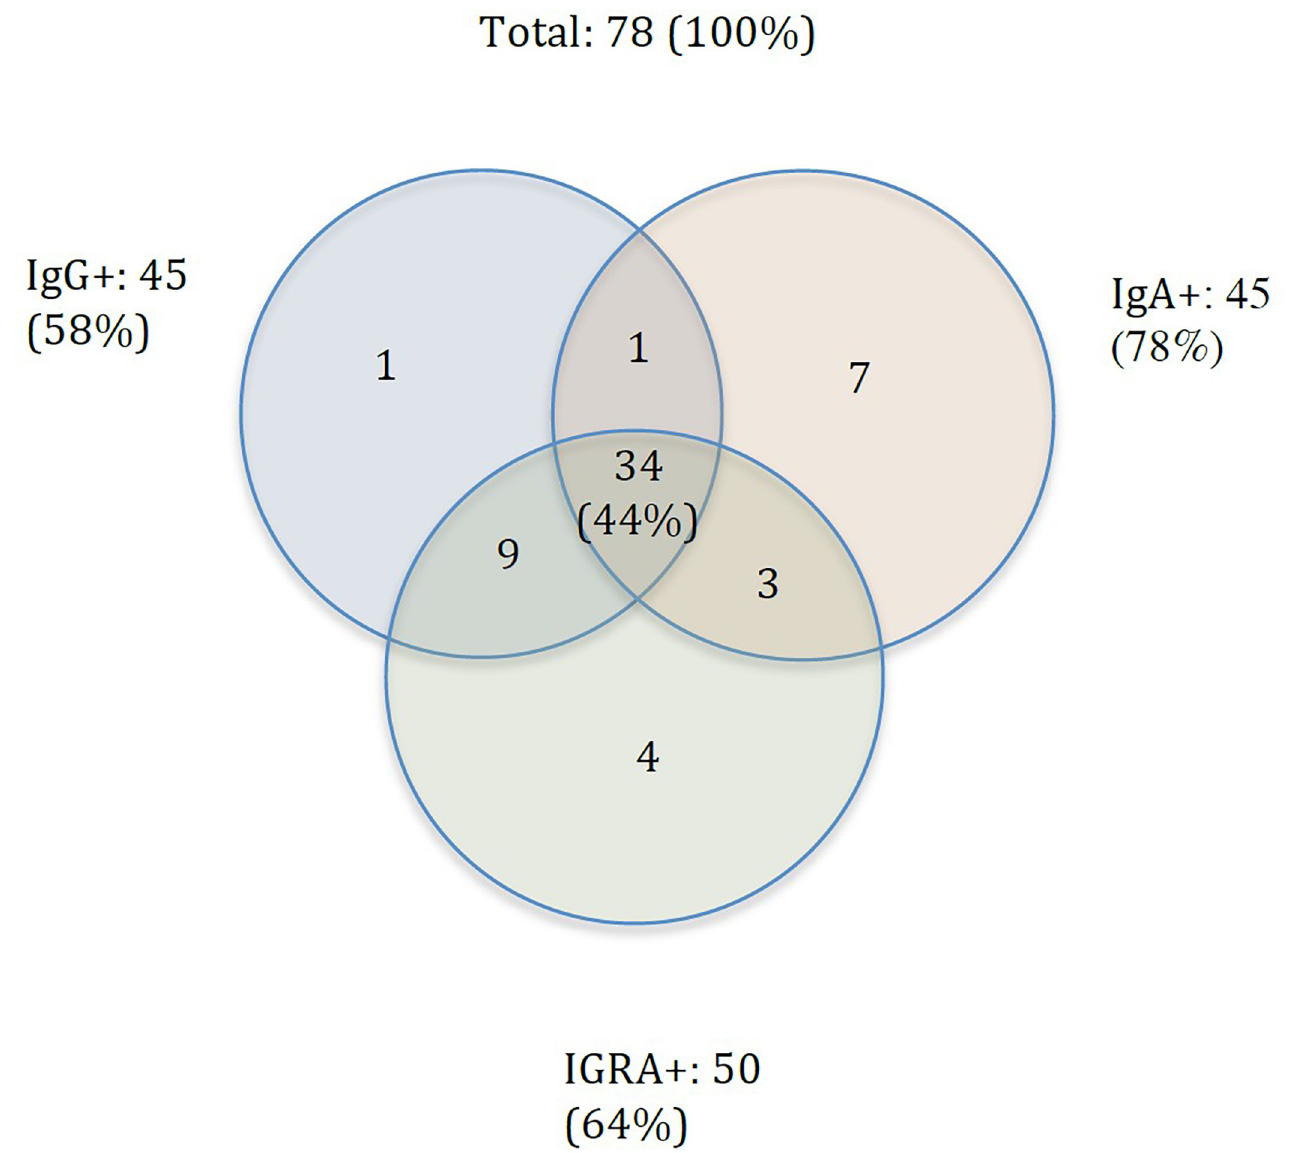
Fig 2. Venn diagram depicting numbers of participants of the test cohort in February 2021 who had all three parameters (IgA, IgG and IGRA) measured (N = 78).